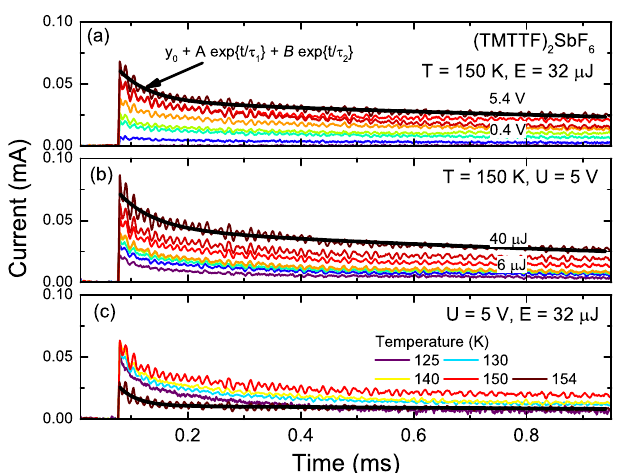
Figure 9. Time-dependent photocurrent of (TMTTF) 2 SbF 6 for ( a ) various voltages; ( b ) laser pulse intensities and ( c ) temperatures as indicated. In all three panels the temporal dynamic is fitted by a double exponential function (black lines).